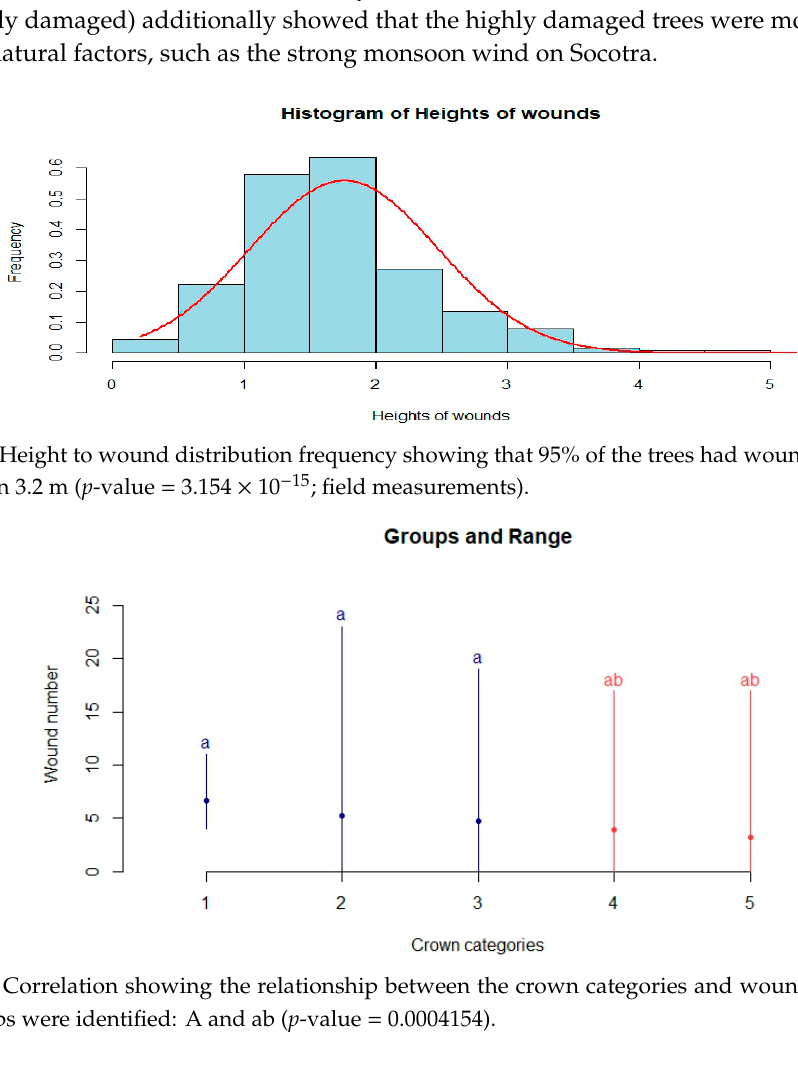
Figure 7. Correlation showing the relationship between the crown categories and wound number; two groups were identified: a and ab ( p - value = 0.0004154).